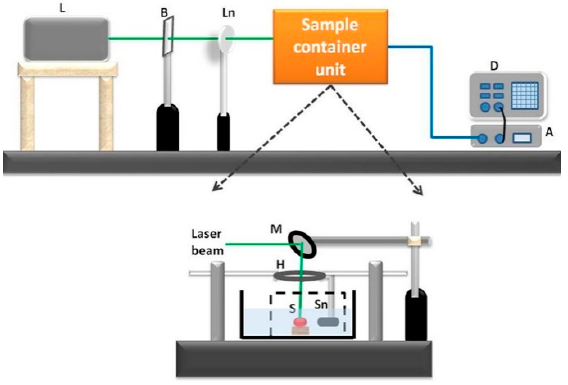
Figure 2. Schematic of PA spectral sensing experimental setup (L-laser; B-beam splitter; Ln-lens; D-digitizer; M-mirror; H-holder; S-sample; Sn-sensor).